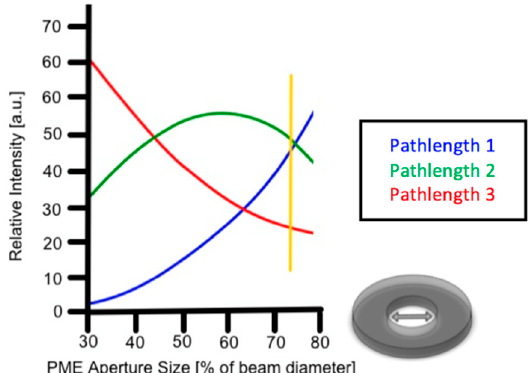
Figure 5. Monte Carlo simulation shows the relative intensity of each pathlength as a function of PME central aperture size (diameter; percent of beam diameter). The intensity of light in pathlength one increases monotonically with PME aperture size, and the intensity of light in Pathlength 3 decreases monotonically with PME aperture size. The intensity of light due to photons in Pathlength 2 increases and then decreases, with an infection point at a PME aperture size (diameter) of about 60% of the OCT beam diameter. The yellow vertical line corresponds to the angular distributions in Figure 4. Permission was granted by the publisher to reprint this figure from Gardner et al. with minor modifications [19].